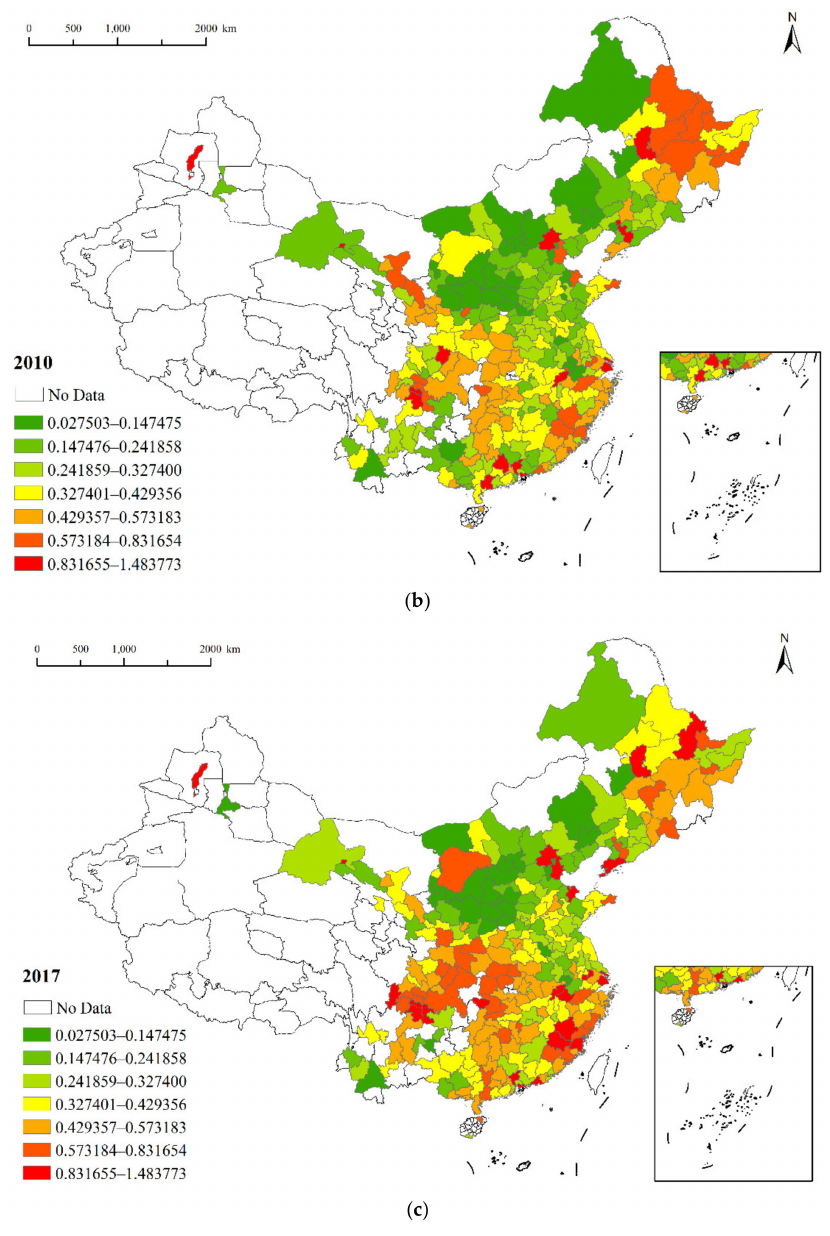
Figure 3. Spatial distributions of city-level CE ( a ) 2003, ( b ) 2010, ( c )